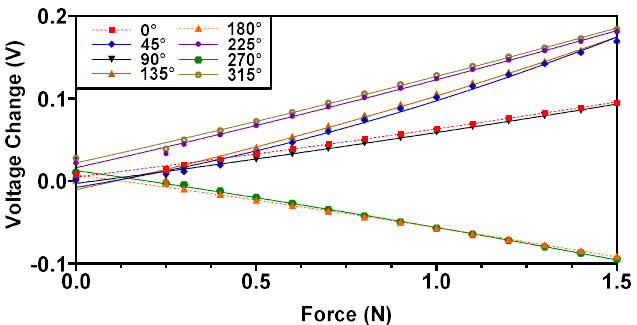
Figure 14. The output voltage response of the proposed magnetic tactile sensor for applied forces at different angles. different